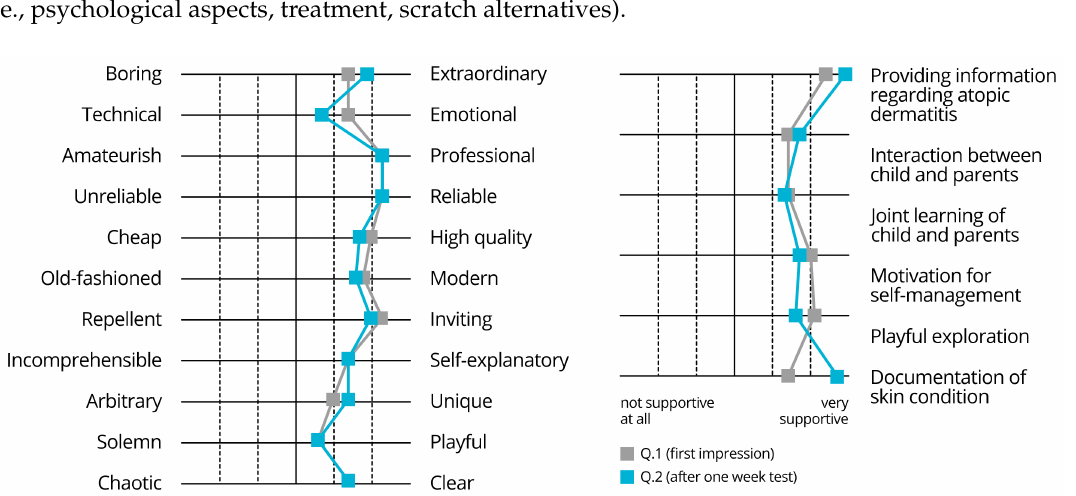
Figure 4. Semantic di ff erential for subjective overall rating (left) and rating of perceived support by atopi box (right), n = 7 families, Q.1 = questionnaire 1, Q.2 = questionnaire